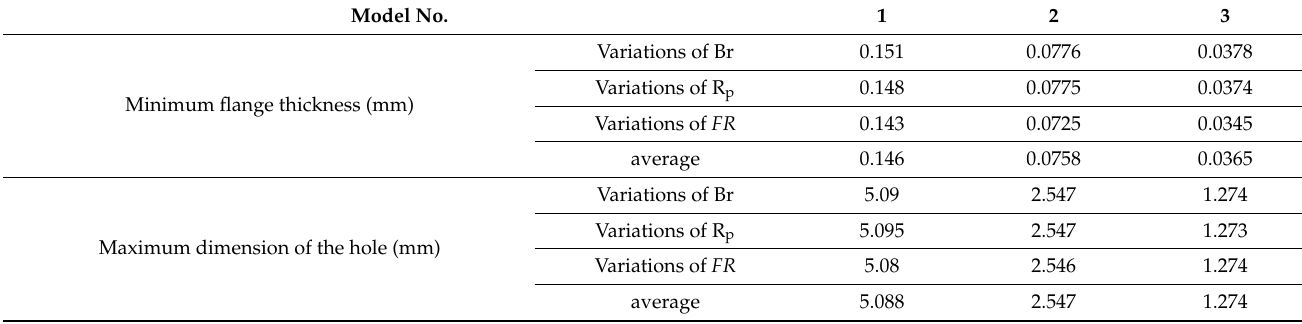
Table 8. Comparisons of minimum flange thickness and maximum dimension of the hole for three models. Model